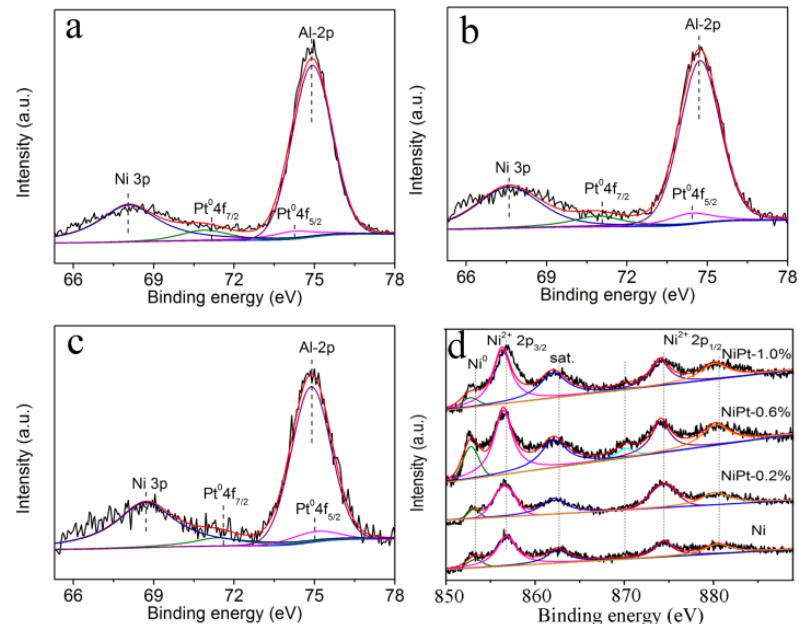
Figure 3. High-resolution transmission electron microscopy (HRTEM) images of the supported catalysts: ( a ) Ni; ( b ) NiPt-0.2%; ( c ) NiPt-0.6%; ( d ) NiPt-1.0%; ( e ) Energy dispersive X-ray spectroscopy (EDS) mapping of the catalyst NiPt-0.6%.